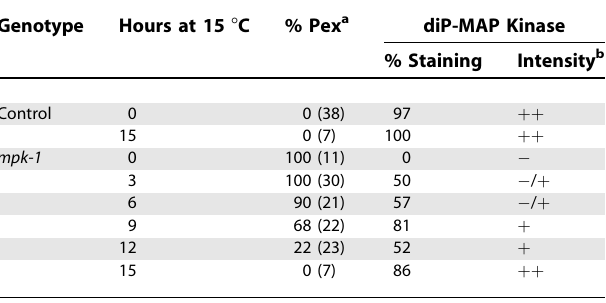
Table 1. Quantification of Meiotic Progression and MAP Kinase Activation after Shift of mpk-1 to Permissive